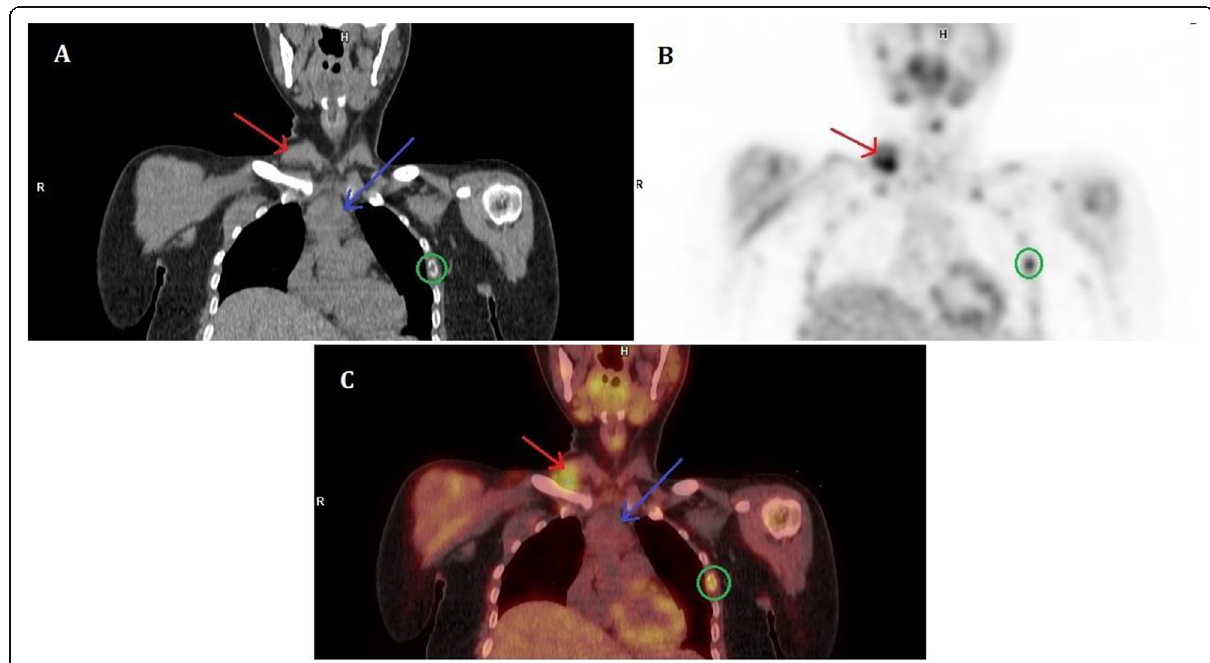
Fig. 3 18 F-FDG PET/CT: A coronal computed tomography image, B coronal PET images, and C fused PET/CT coronal image. There are FDG-avid